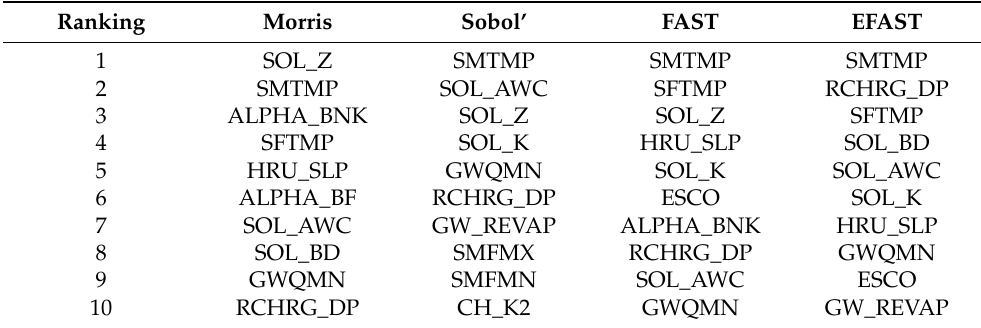
Table 3. Comparison of sensitive parameters calculated with different methods.